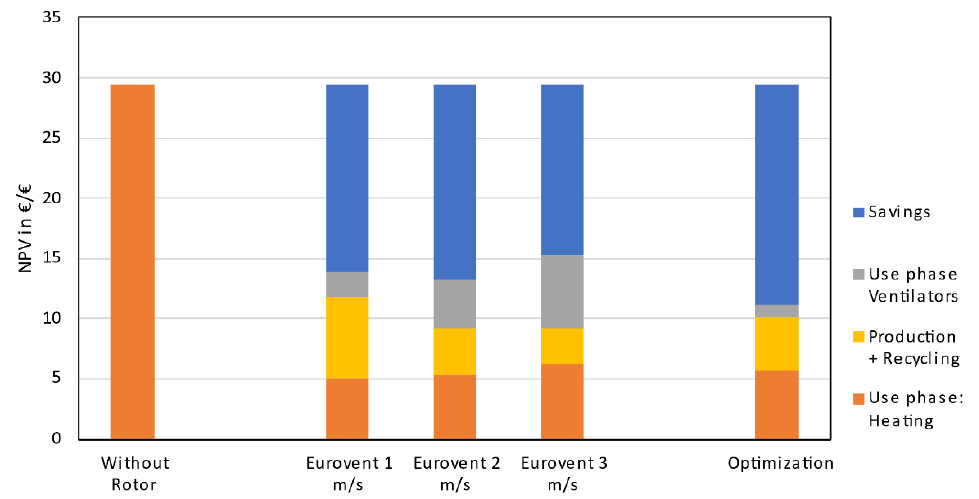
Figure 9. 25 € /t CO 2 Eq. scenario with optimized RHX and Eurovent RHX under different operating ambient air empty tube velocities at 10,000 m 3 /h.